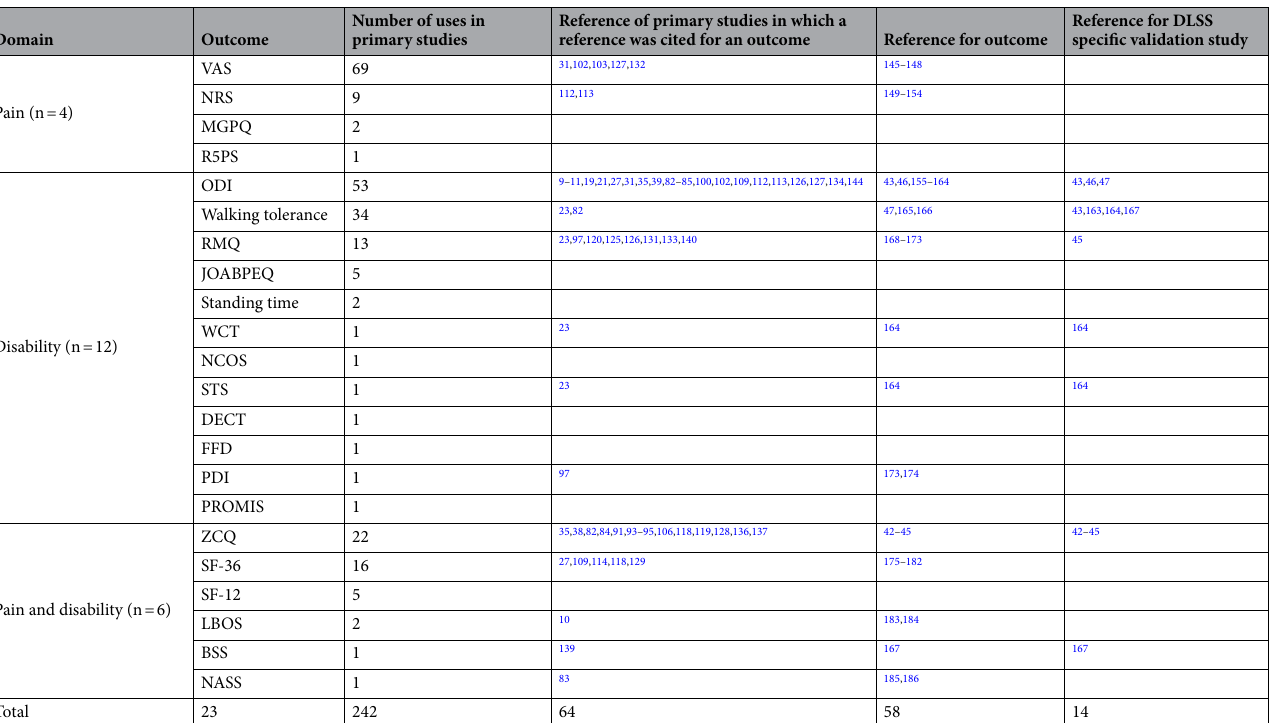
Table 3. Outcome measures in the domain of pain and disability. BSS Beaujon scoring system; DECT Digitest ergojump contact test; FFD Finger floor distance; JOA Japanese orthopedic association back pain evaluation questionnaire; LBOS Low back outcome score; MGPQ McGill pain questionnaire; NASS North American spine society instrument; NCOS Nlaudicationaudicatio outcome score; NRS Numeric rating scale; ODI